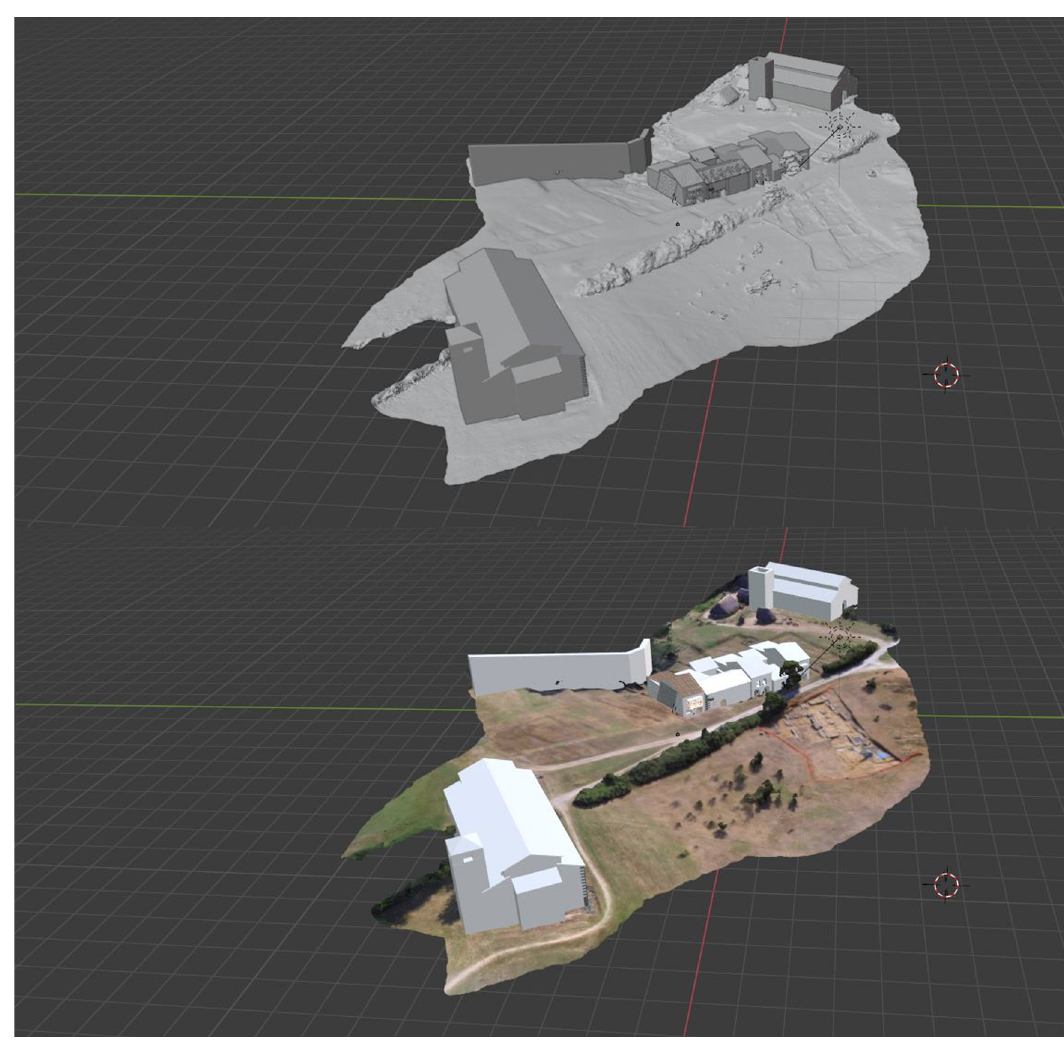
Figure 6: 3D rendering of a neighborhood of Podium Bonizi in